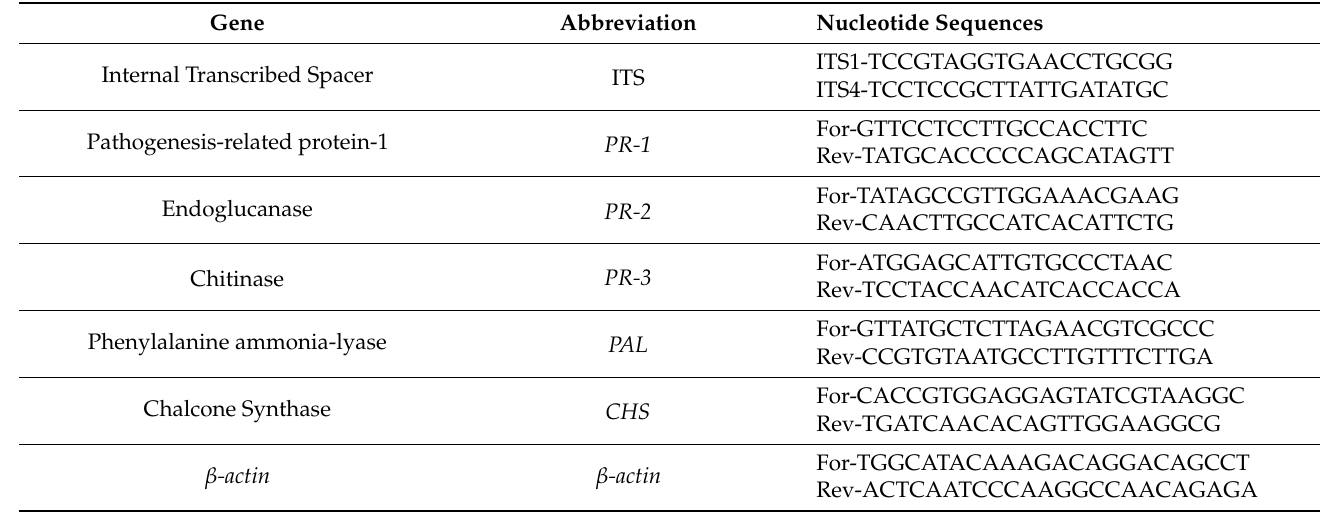
Table 1. Oligonucleotide primers used in this